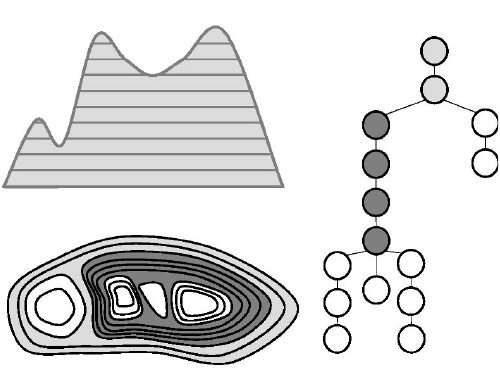
Figure 1: Contour tree and map. Branches at the bottom of the structure (white contours) represent peaks and pits.